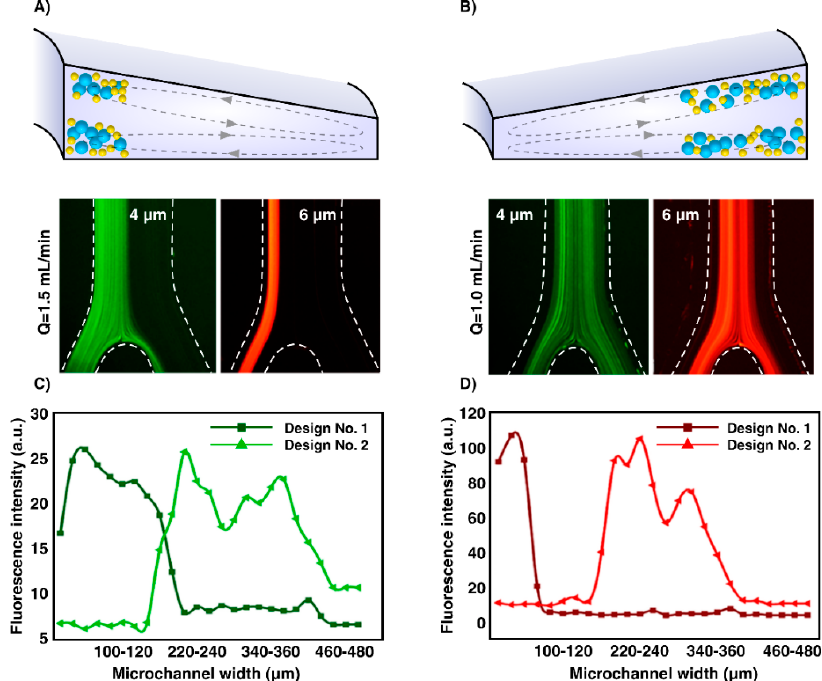
Figure 3. Schematic and top view experimental observation of fluorescently labeled particles indicating the inertial focusing of 4 µm and 6 µm beads in ( A ) Design No. 1 and ( B ) Design No. 2 at the optimal flow rate (1.5 mL/min). The plot of fluorescent intensity against channel width indicates the distribution of ( C ) 4 µm (green) and ( D ) 6 µm (red) particles flowing in the spiral Design No.1 and Design No.2 devices as a function of channel cross-sectional geometry.